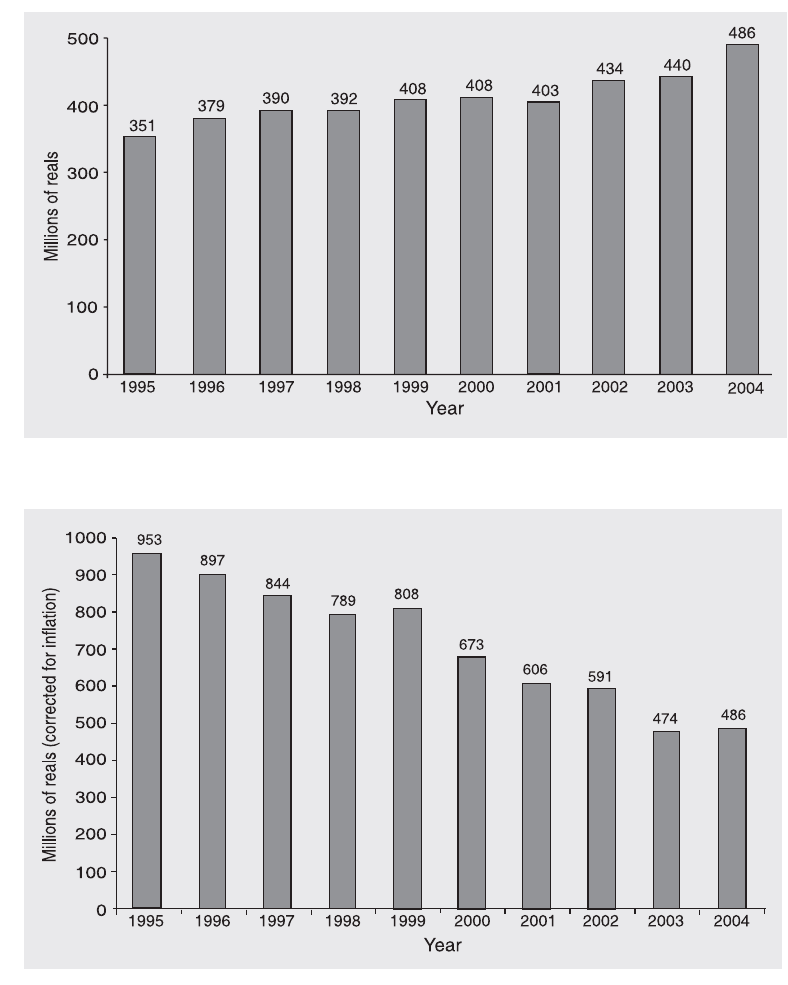
Figure 7. Funds spent by CAPES on scholarships be- tween 1995 and 2004 (original data source: CAPES, http://www.capes.gov.br/capes/portal).